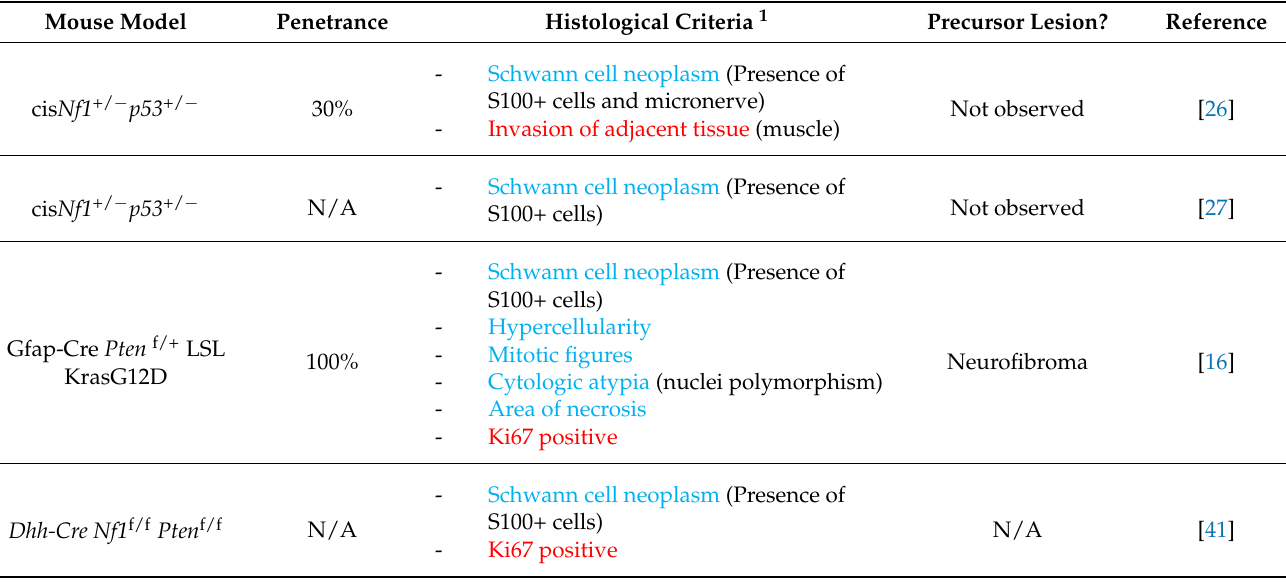
Table 1. Histological criteria to confirm the diagnosis of MPNST mouse models. Mouse